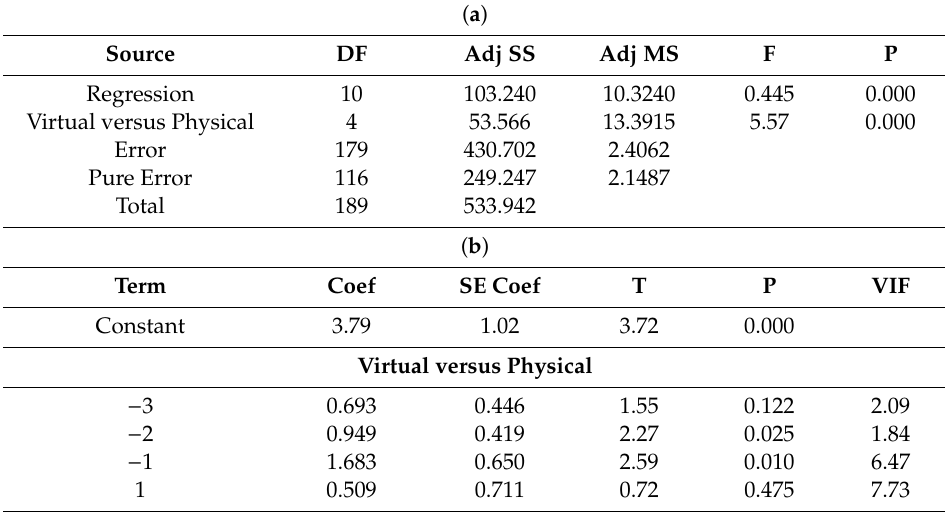
Table 10. ( a ) ANOVA for the valence construct of the dirt-o ffl oading task with di ff erent feedbacks. ( b ) Multiple comparisons of the valence construct for integrated feedback.